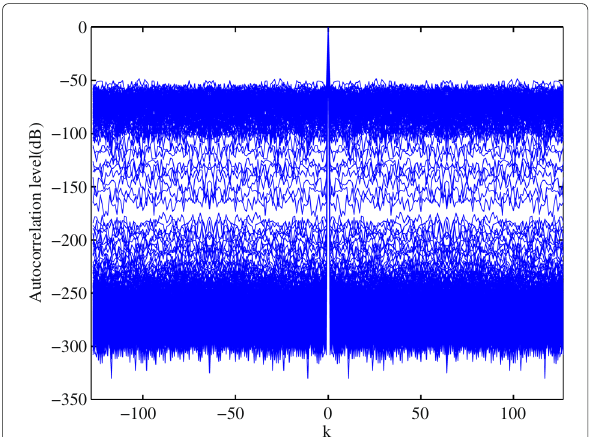
Fig. 2 Autocorrelation level of the sequences generated by ADMM